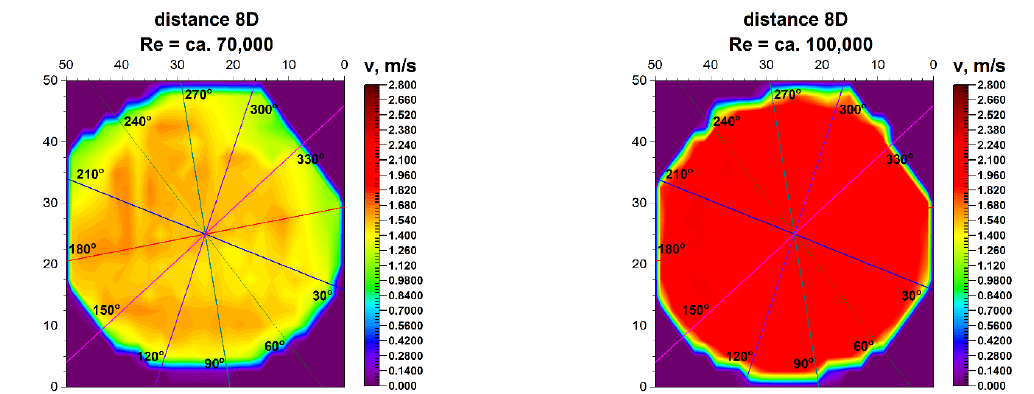
Figure 17. Comparison of projections on the velocity blocks the distances 8D from the disturbance with marked cross- sections for Re ≅ 70,000 and 100,000.